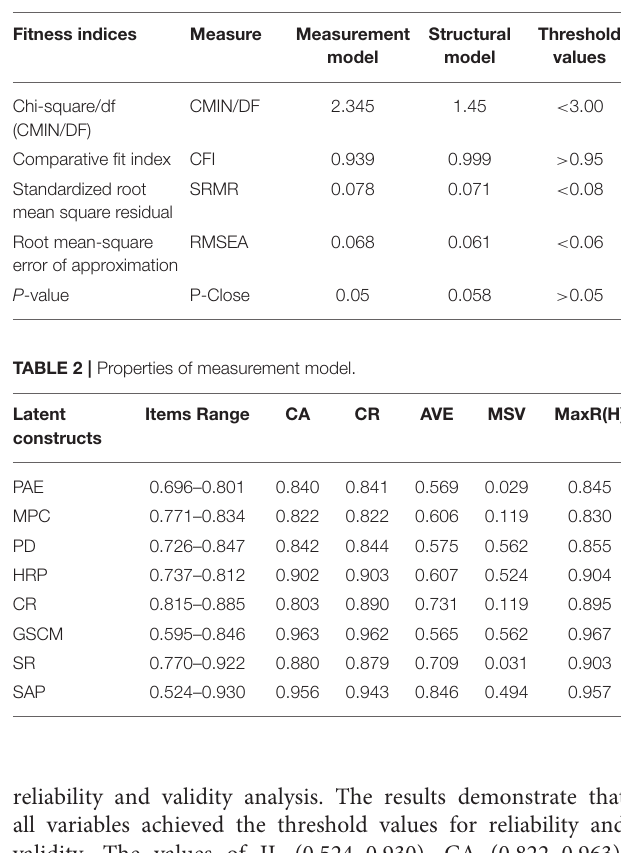
TABLE 1 | Model fit indices.